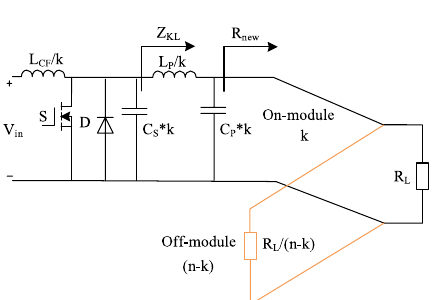
Fig. 6 Equivalent circuit when k is